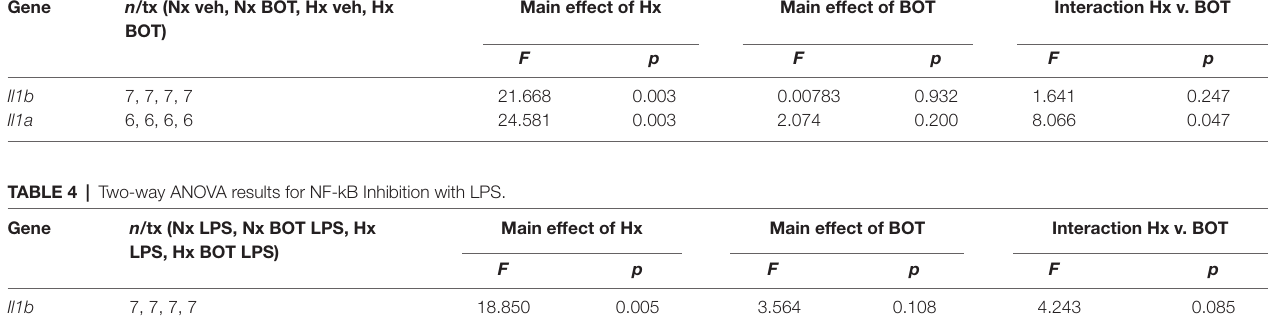
TABLE 3 | Two-way ANOVA results for NF-kB Inhibition without lipopolysaccharide (LPS). Gene